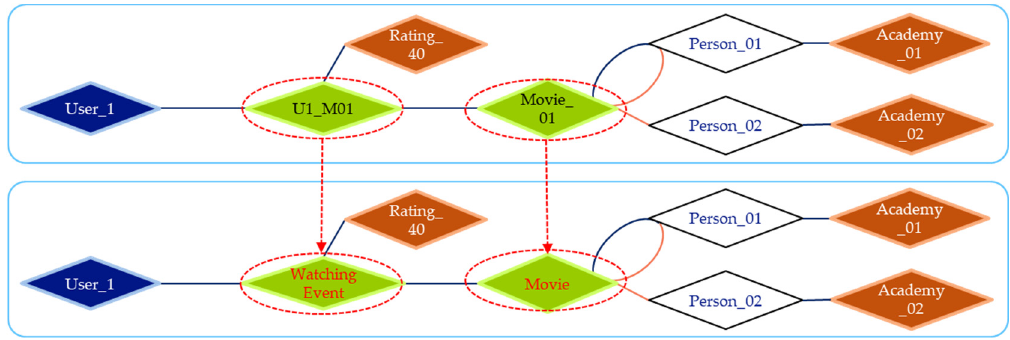
Figure 10. Process of applying the chunking option.